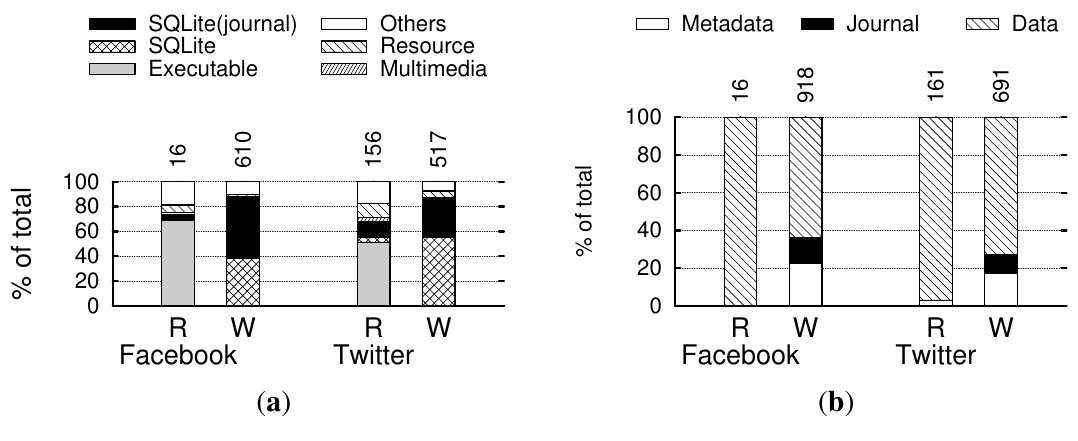
Figure 14. I/O distribution of file types and block types. ( a ) File types; ( b ) Block types. The number on the top of each bar indicates the number of respective block I/O for R (Read) and W (Write), respectively. [Samsung Galaxy S4, Android 4.2.2 (JB),